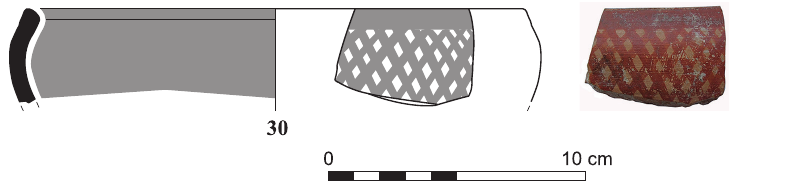
Fig 29. Fragment of a Greek shallow bowl from Sidon phase F dating to the Middle Geometric I / Subprotogeometric IIIA.